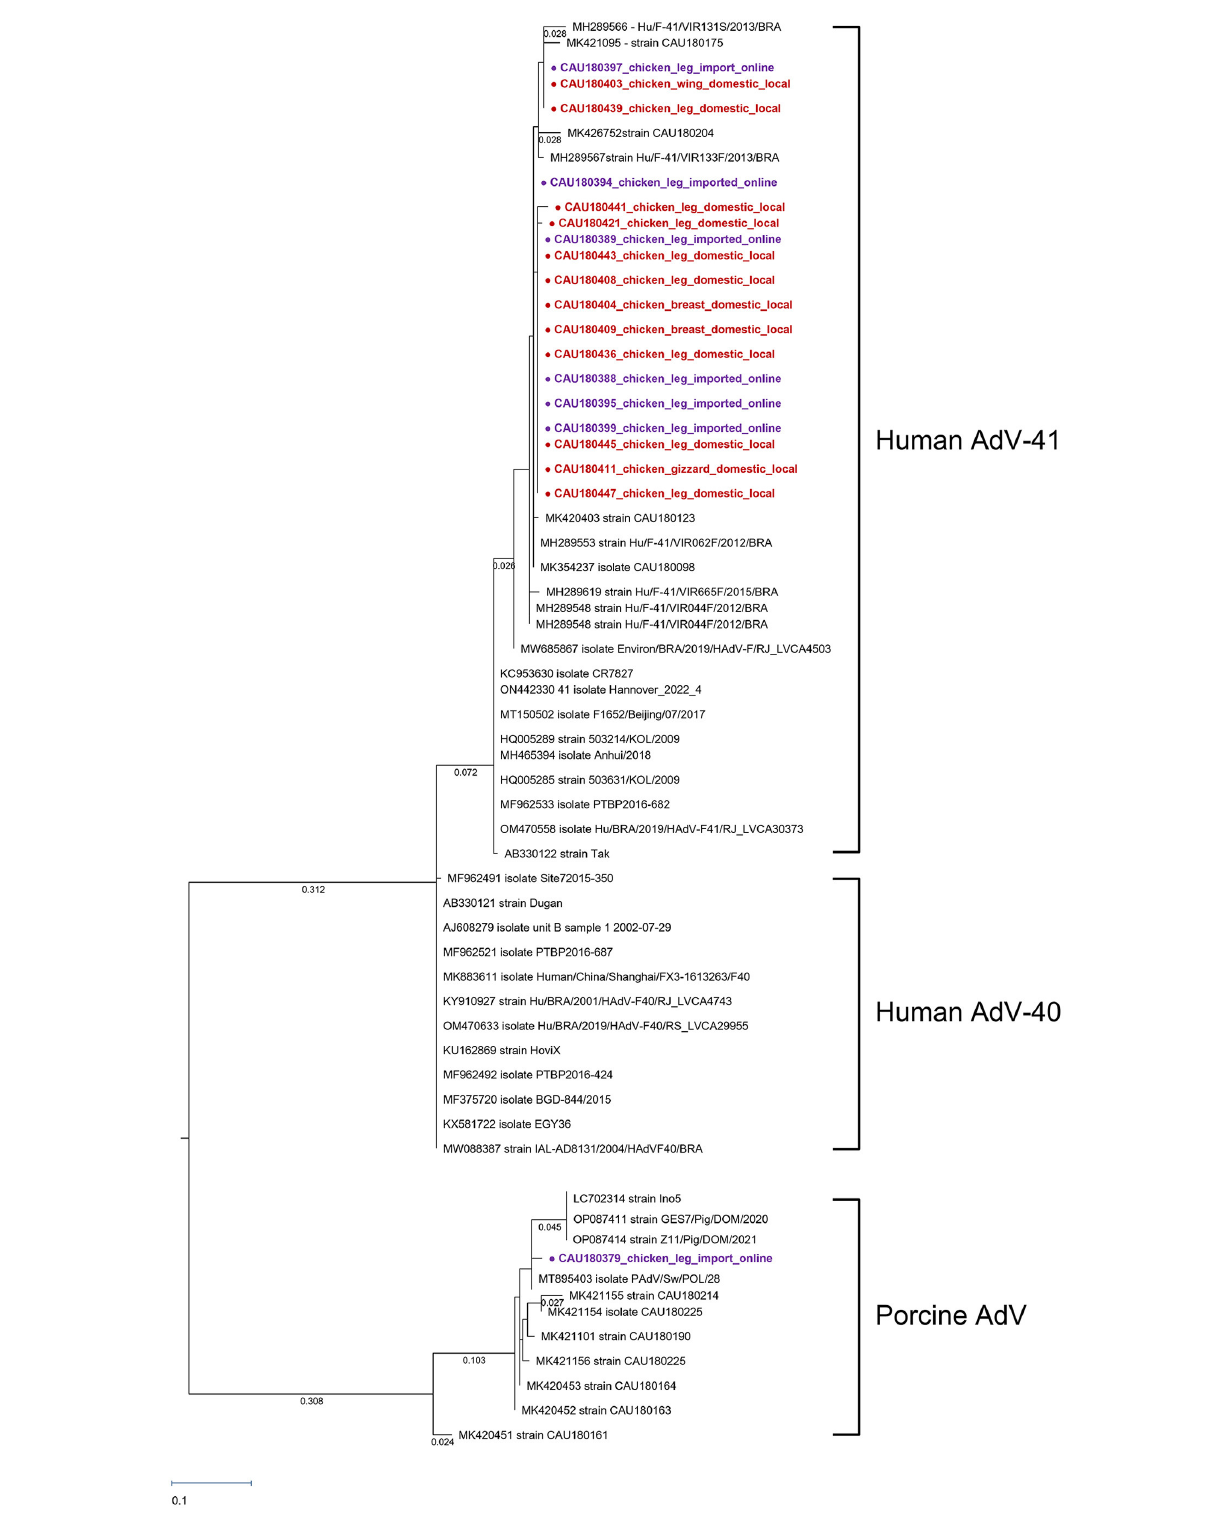
FIGURE2 Phylogenetic tree of AdV detected in chickens. Sequences detected in this study are represented as circles ( ). The red circles ( ) were AdV samples purchased in local markets, and the purple circles ( ) were AdV samples purchased in online markets. Phylogenetic tree analysis for the AdV hexon gene using the maximum likelihood method and based on the 171-bp sequence. The numbers of compressed sequence distances were shown in